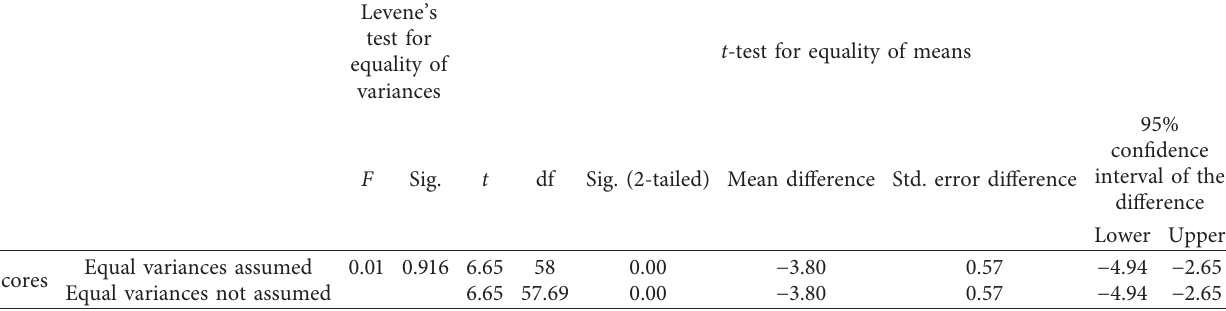
Table 4: Independent-samples t -test (reading comprehension posttest).